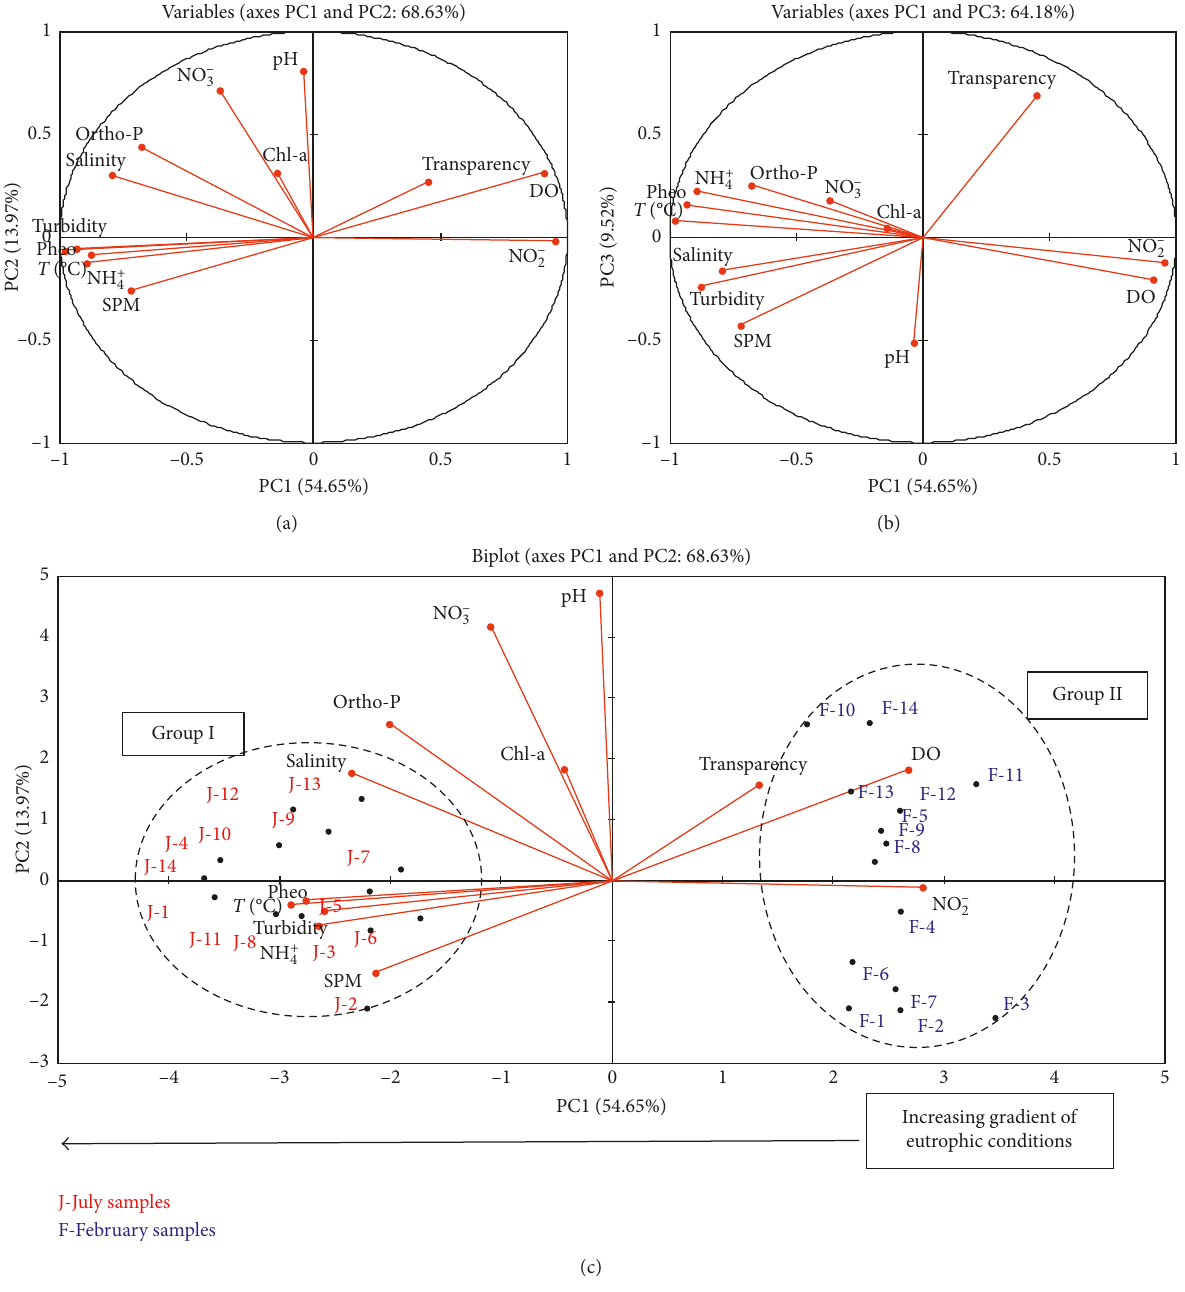
Figure 11: Circle of correlation on (PC1 and PC2) and (PC1 and PC3) and spatial distribution of variables and individuals in the axes system PC1 and